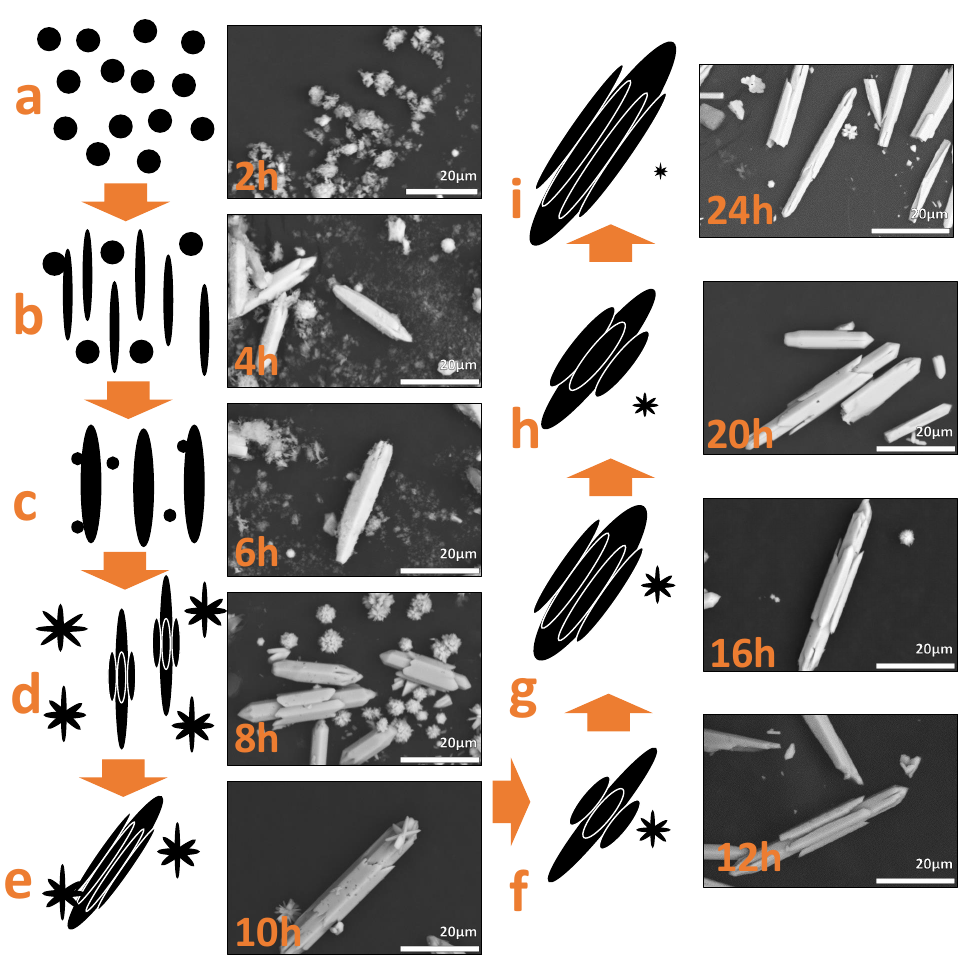
Figure 10 Schematic illustration for the formation of the Y(OH) 3 using the results of each reaction